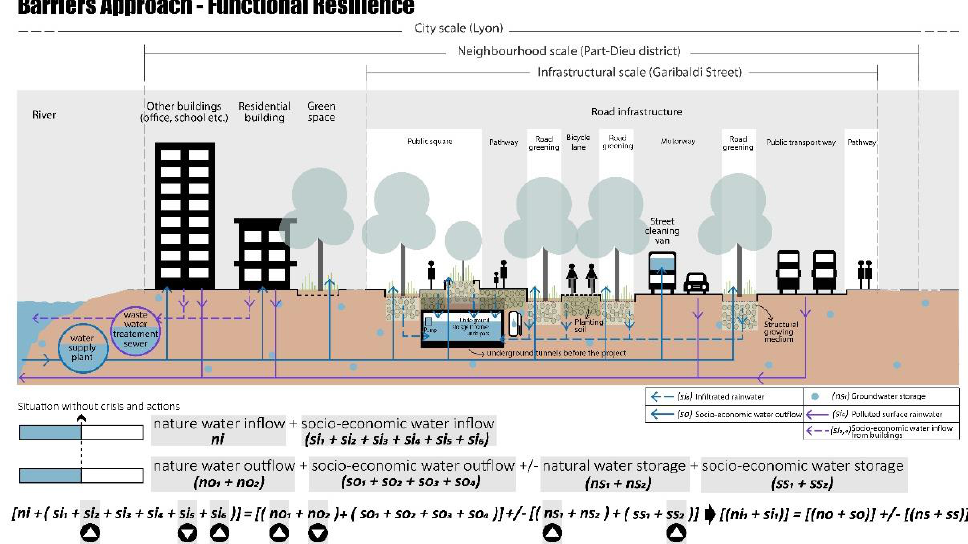
Figure 7. Inside the “barrier”, functional resilience Garibaldi project, no-crisis scenario (NCS), realised by authors, adapted from TDAG [101].